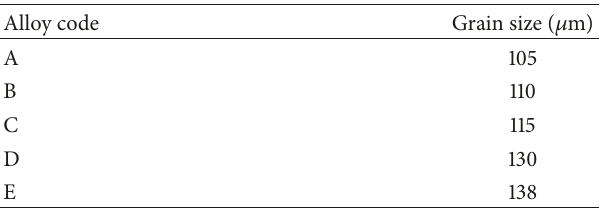
Table 2: Average grain size of the phases in the alloys used in the present